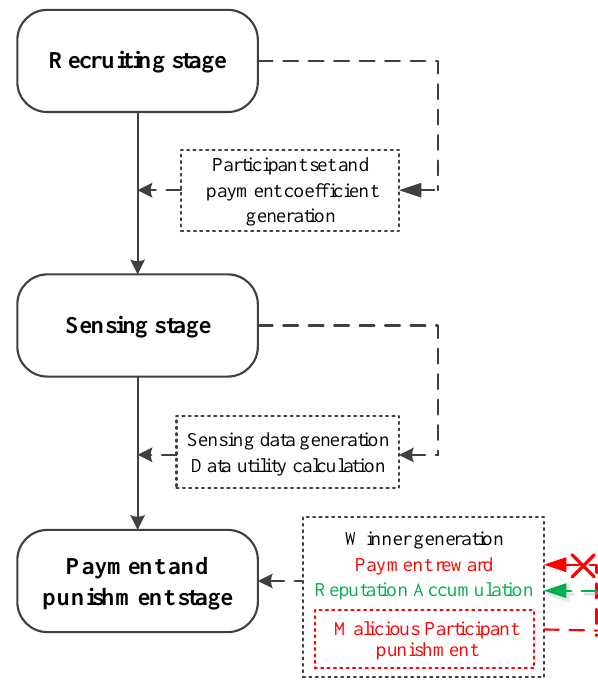
Figure 7. Flow of staged incentive and punishment